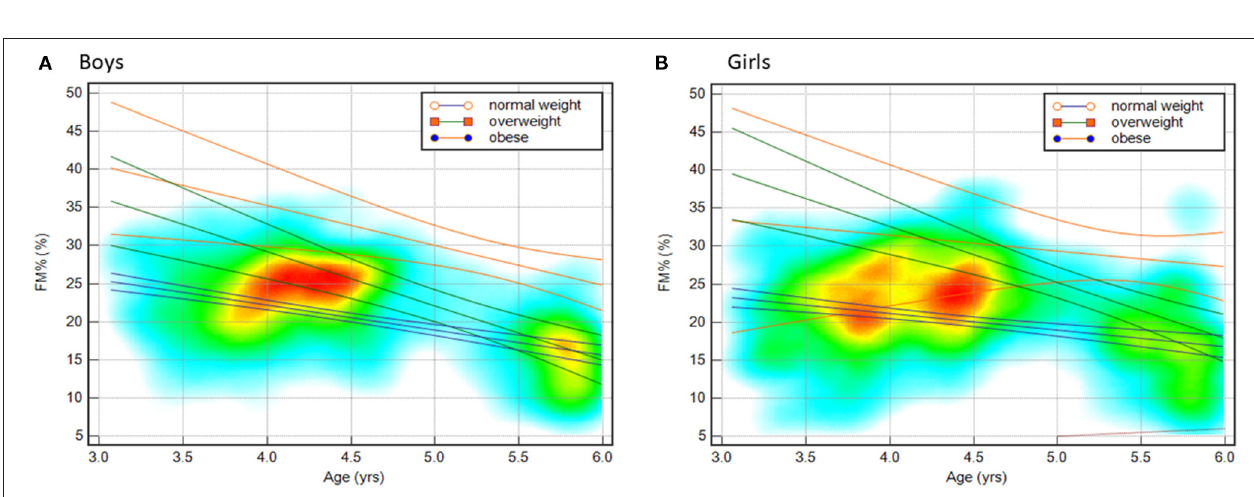
FIGURE 2 | [ (A) Boys; (B) Girls] Scatter-diagram heatmap and regression lines for the percentage of fat mass (FM%) plotted by age for boys (A) and girls (B) . The blue lines indicate the best-fit line and the upper and lower 95% confidence limits of normal-weight children. The green lines indicate those of overweight children, and the orange lines indicate those of children with